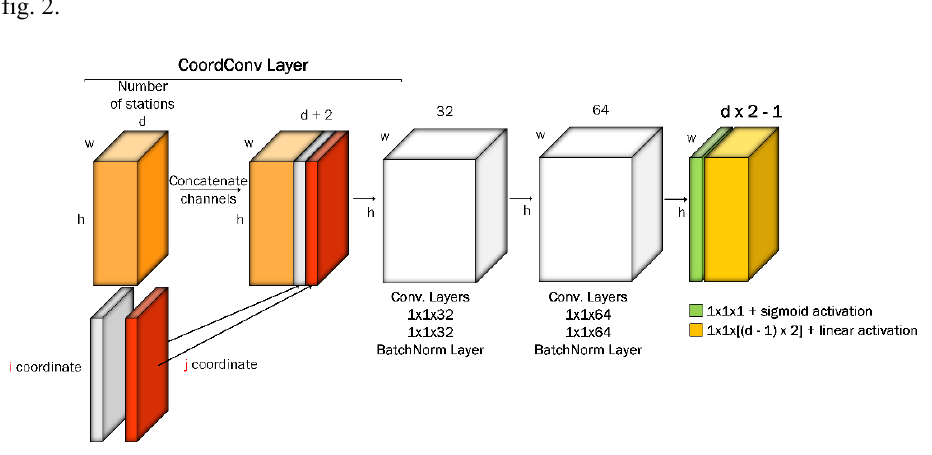
Table 1. Results of applying several metrics to the trained network for different input length.